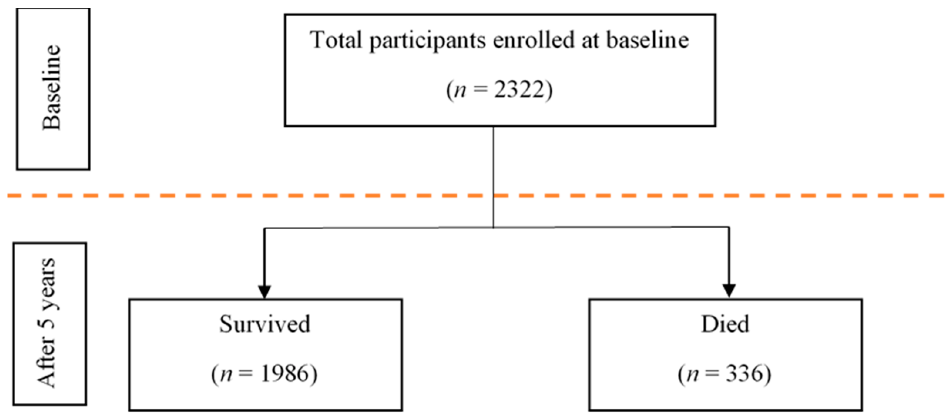
Figure 1. Illustration of the number of respondents at baseline and after five years follow up.